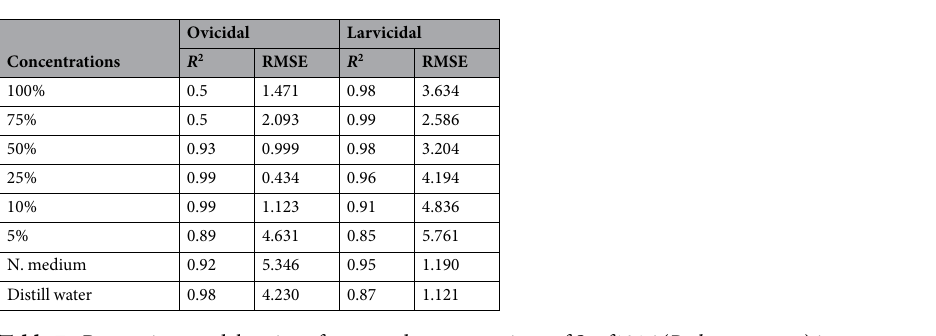
Table 7. Regression model various fermented concentrations of Snef1216 ( P. chrysogenum ) in response to ovicidal and larvicidal